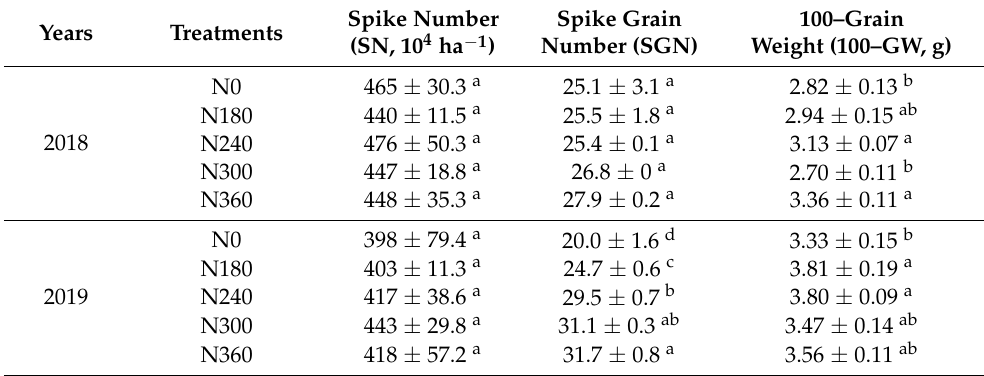
Figure 2. Spring wheat, summer maize and annual cereal grain yields in response to the N application rate. Note: The lowercase letters above bar graph indicate the significant differences at p < 0.05 levels, and the regression equation correlation coefficients are significant at * = p < 0.05 and ** = p < 0.01. Table 1. Effect of the nitrogen application rate on the spring wheat grain yield composition.